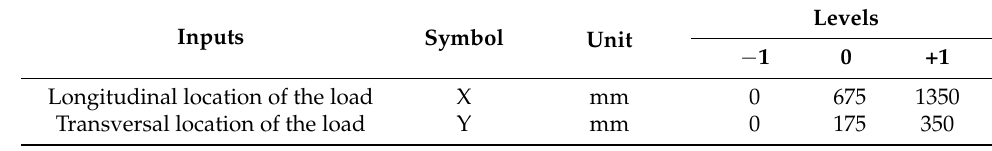
Table 1. Design of experiments: inputs, units, and levels.